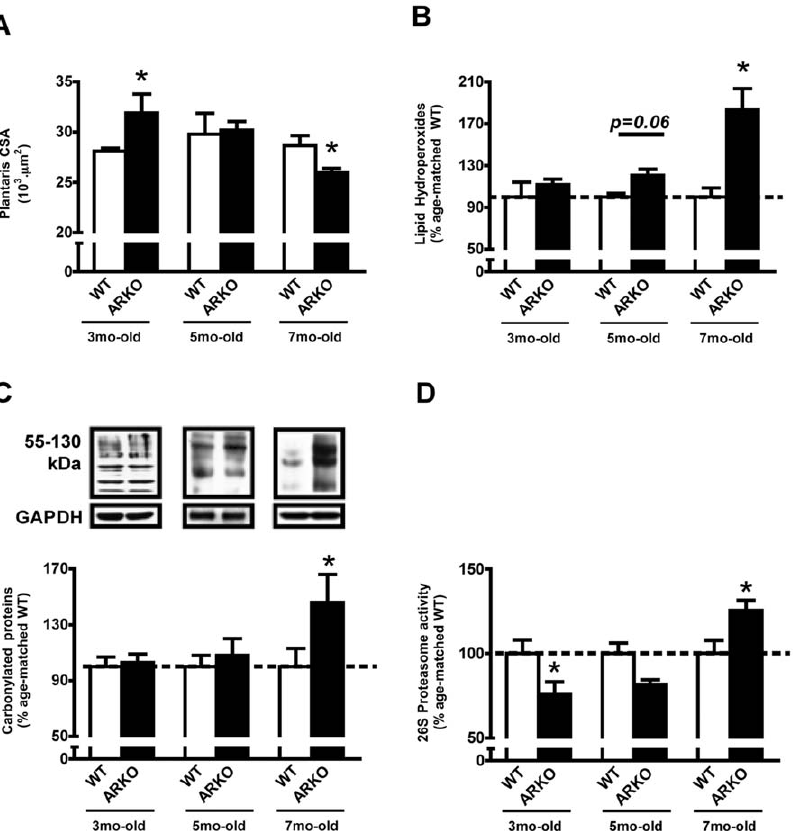
Figure 2. Plantaris trophicity, oxidative stress and chymotrypsin-like proteasomal activity in a 2A / a 2C ARKO mice. Plantaris muscle cross-sectional area (CSA) (A), lipid hydroperoxidation (B), protein carbonylation (C) and chymotrypsin-like proteasome activity (D) in 3, 5 and 7 month-old wild type (WT) and a 2A / a 2C ARKO mice (ARKO). Immunobloting data are shown as percentage of age-matched WT group (set to 100%)). Representative images of immunoblots are shown below respective charts. Data are presented as mean 6 standard error from mean. *p , 0.05 vs.